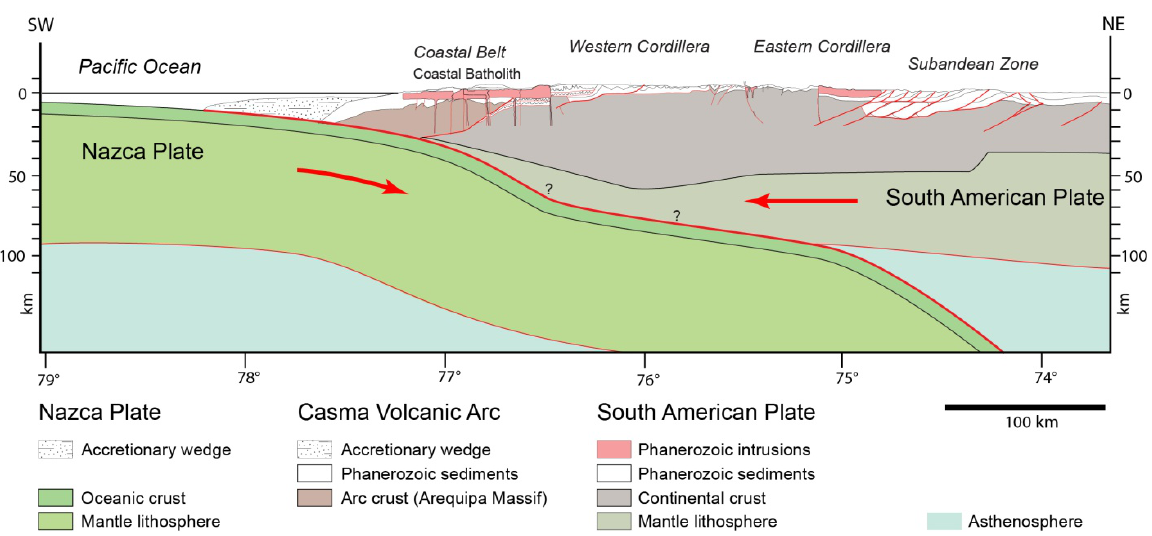
Figure 3. General cross-section showing the geometry of the plate boundary in the subduction zone and the crustal structure of the Andes [8–11]. Upper crustal structure of the Andes after own